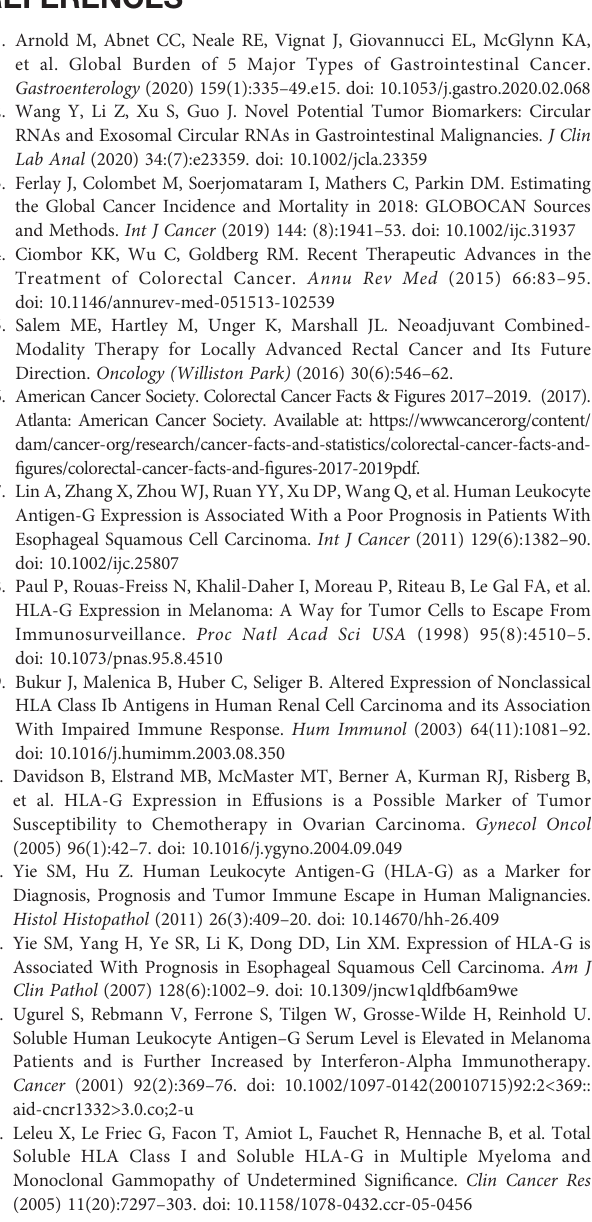
Supplementary Figure 1 | (A, C) Subgroup analysis of the correlation between HLA-G expression and overall survival (OS) in patients with gastrointestinal (GI) cancer according to the different cancer types. (B, D) Subgroup analysis of the correlation of HLA-G expression with OS in patients with GI cancer according to the different antibodies used for detection. Supplementary Figure 2 | (A, C, E) Subgroup analysis of the correlation between HLA-G expression and clinical stage, tumor status or nodal status for different cancer types. (B, D, F) Subgroup analysis of the correlation between HLA-G expression and clinical stage, tumor status or nodal status for different cancer types. Supplementary Figure 3 | Funnel plot: (A) positive vs. negative HLA-G expression (univariate analysis), (B) positive vs. negative HLA-G expression